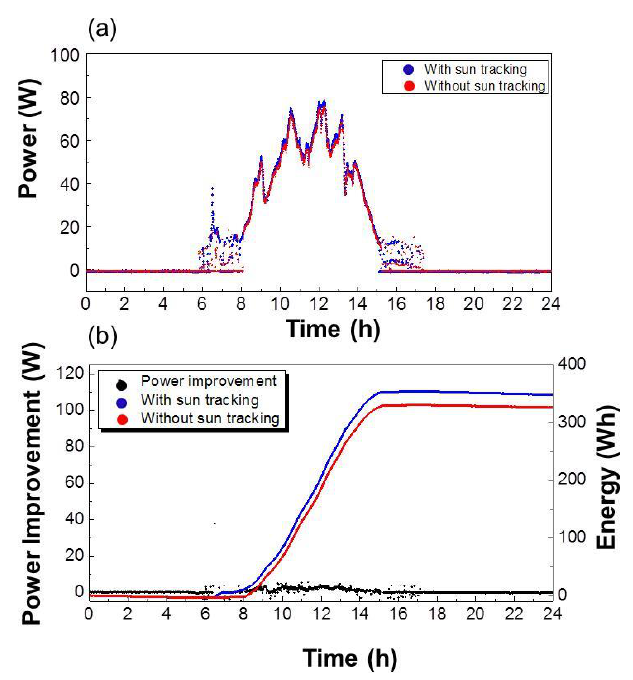
Figure 8. ( a ) Power generation and ( b ) power improvement and energy gain on a rainy day.